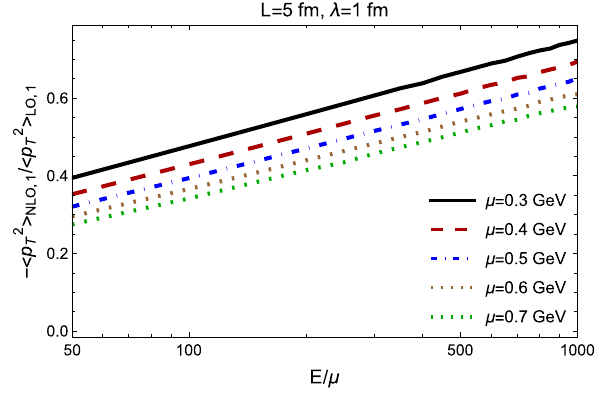
Fig. 11 The ratio of (first-order) NLO to LO broadening of a massless parton as a function of E /μ , for various values of μ . For all values of μ considered, we observe a clear negative logarithmic dependence of the ratio on E